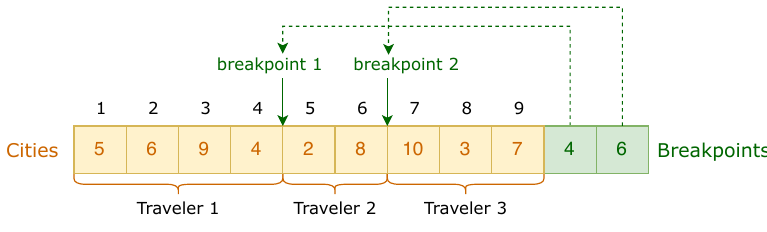
Figure 4. Encoding method for an example chromosome.